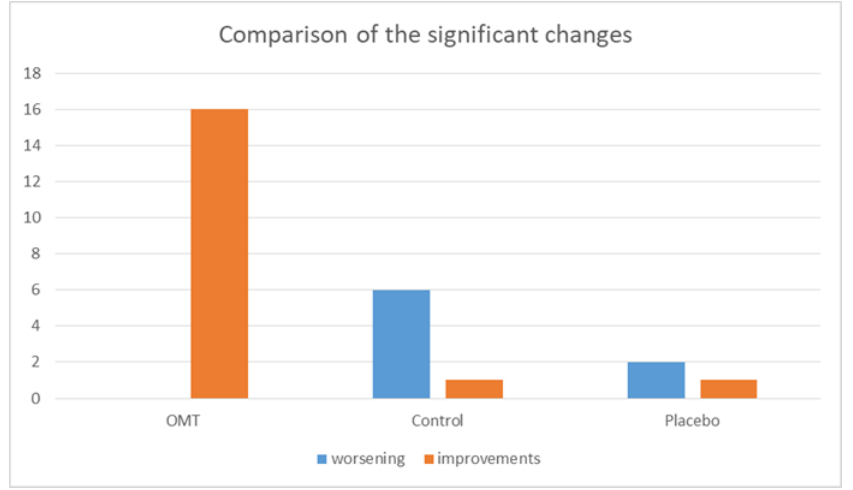
Figure 4. Quality of the significant changes inside each group, considering electromyographic indexes: all the variations in OMT group can be considered improvements whereas the ones in Control and Placebo groups seem more randomly distributed, with a worsening of the absolute value of sEMG indexes.